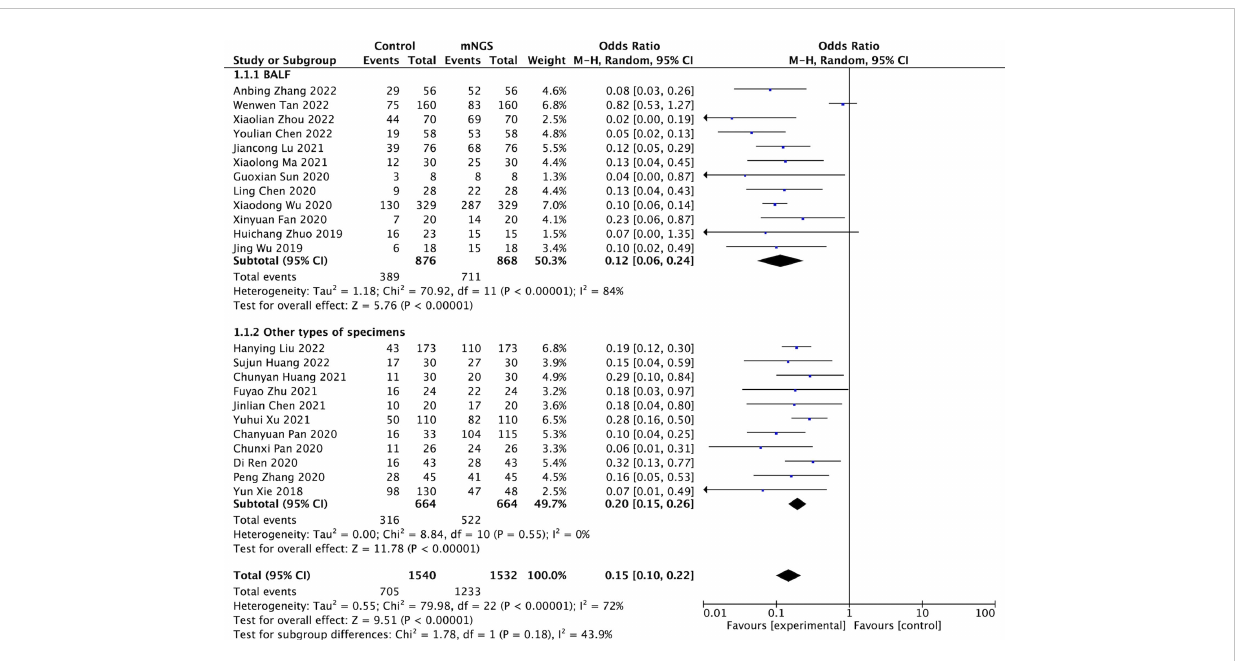
FIGURE 2 Comparison of pathogen detection positive rate between mNGS and conventional methods